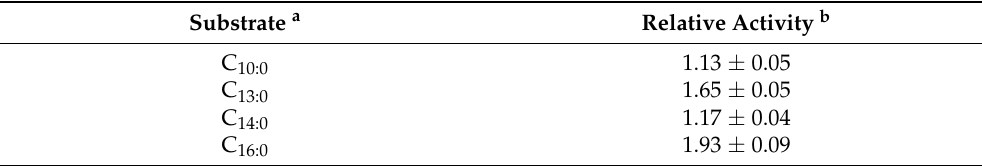
Table 3. Substrate spectrum analysis of